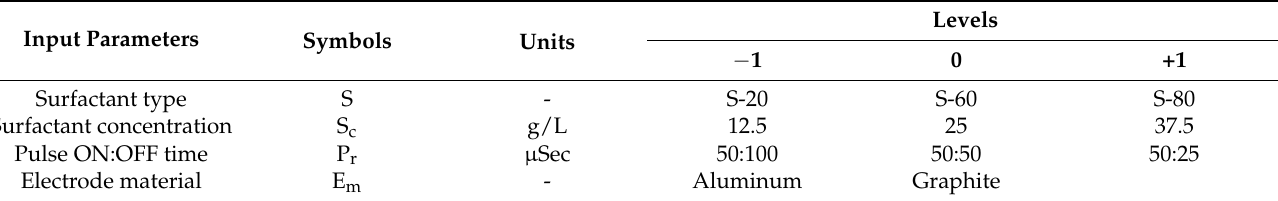
Table 4. Input control parameters for machining of